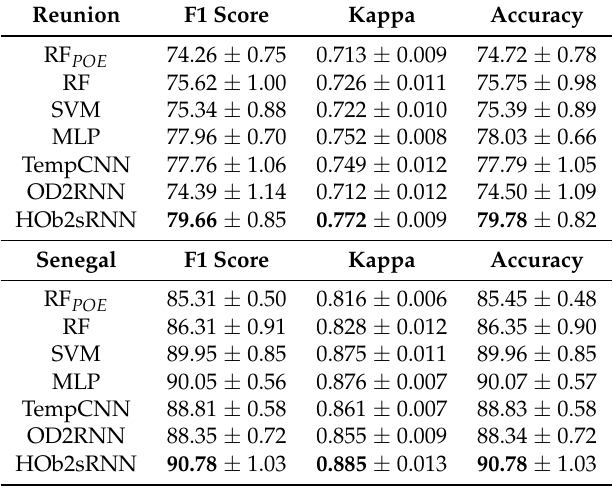
Table 5. F1 score, Kappa, and Accuracy considering the different methods on each study site (results averaged over ten random splits). We have highlighted the best scores in